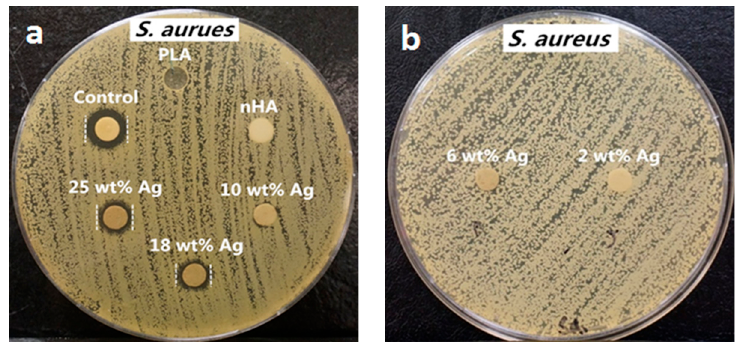
Figure 10. Macrographs of agar plates showing bacterial inhibition zones against S. aureus : ( a ) control (AgNO 3 ), PLA, PLA/18 wt% nHA, PLA/18 wt% nHA–10 wt% AgNPs, PLA/18 wt% nHA–18 wt%